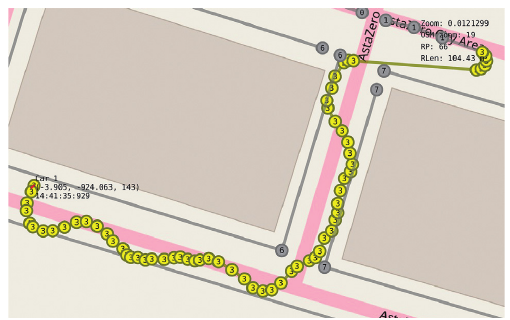
Figure 10: Recovery trajectory generated without optimization, length: 104.4m.